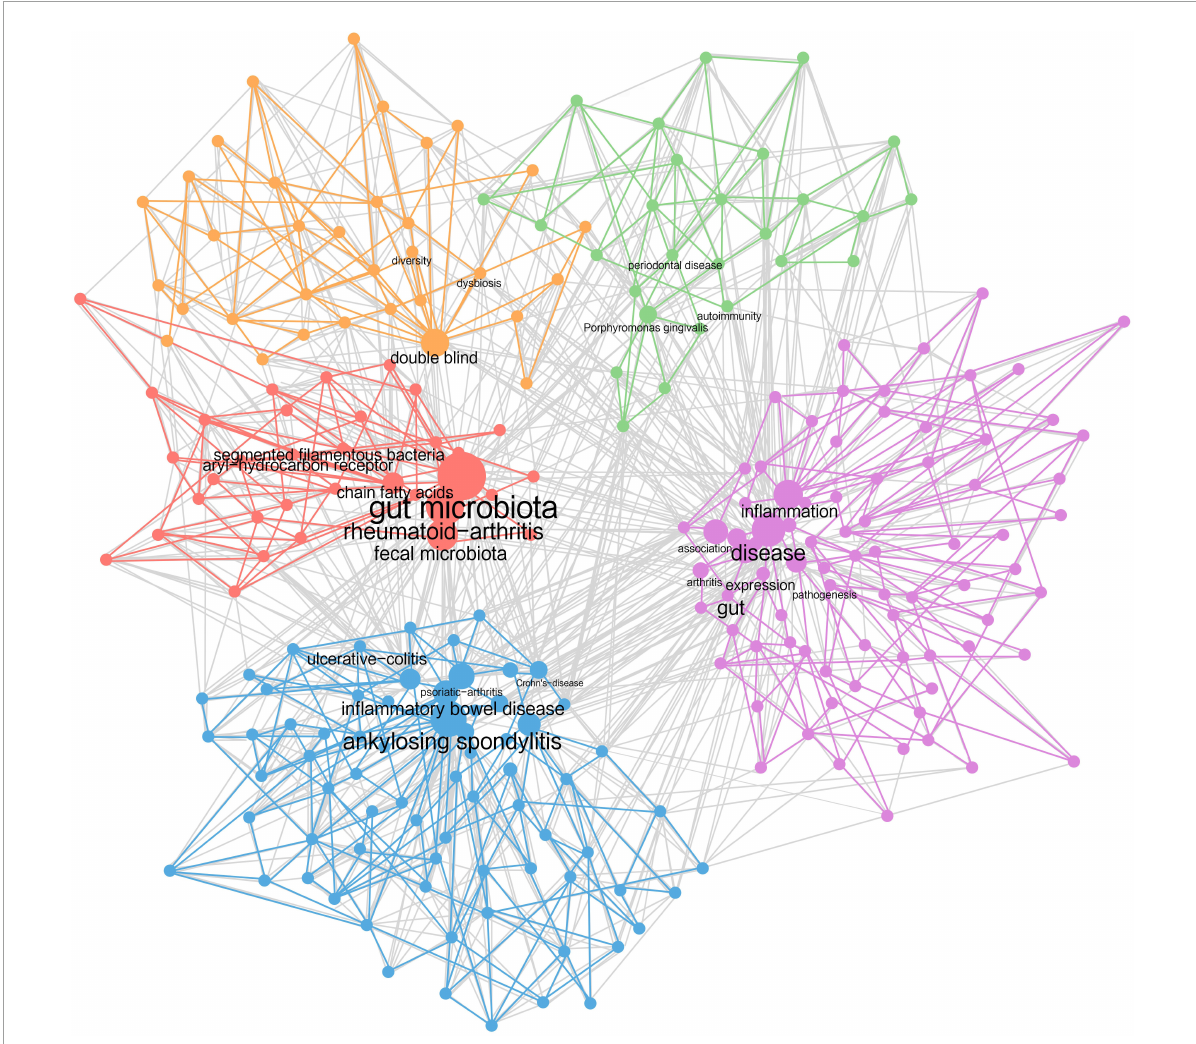
FIGURE4 Keyword co-occurrence network. Each dot represents a keyword. The higher the frequency it has, the bigger the dot is. Keywords showing up in the same document are wired together, forming five clusters of dots of different